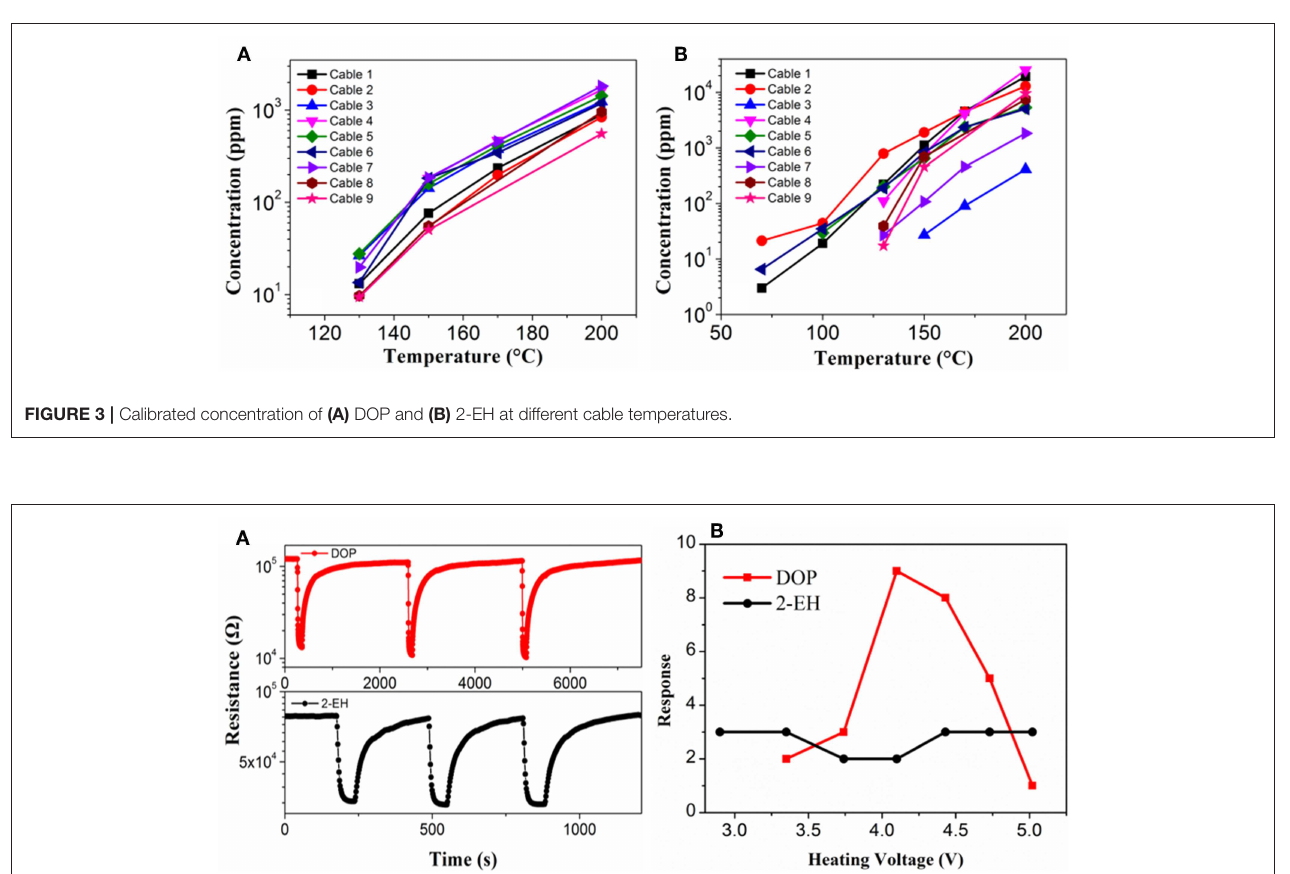
Frontiers in Materials |